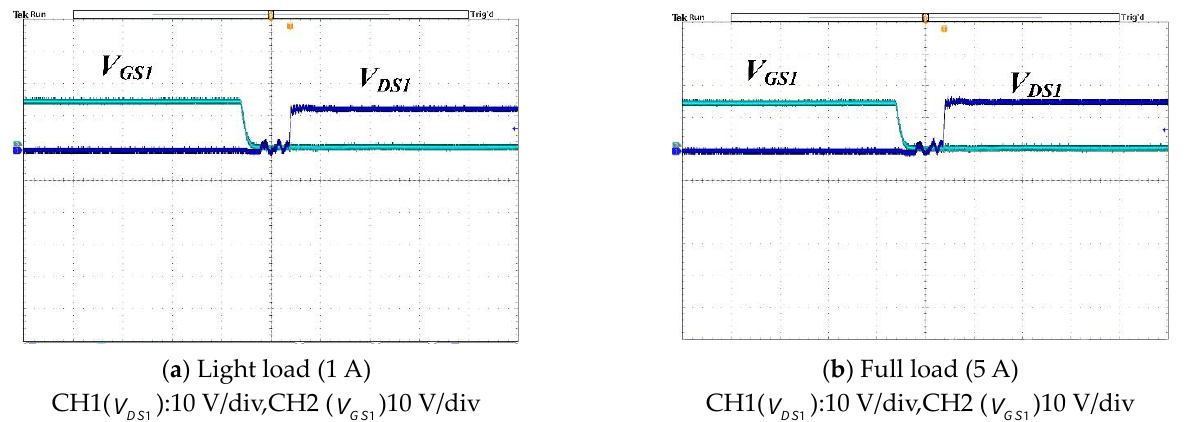
Figure 18. Zero-voltage switching waveforms: ( a ) light load, ( b ) full load.